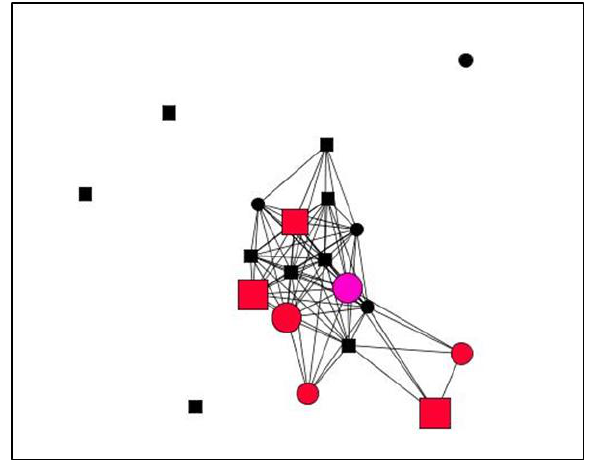
Figure 3. Graph Case 7. Man, 66 years old, 18 years with chronic pain.